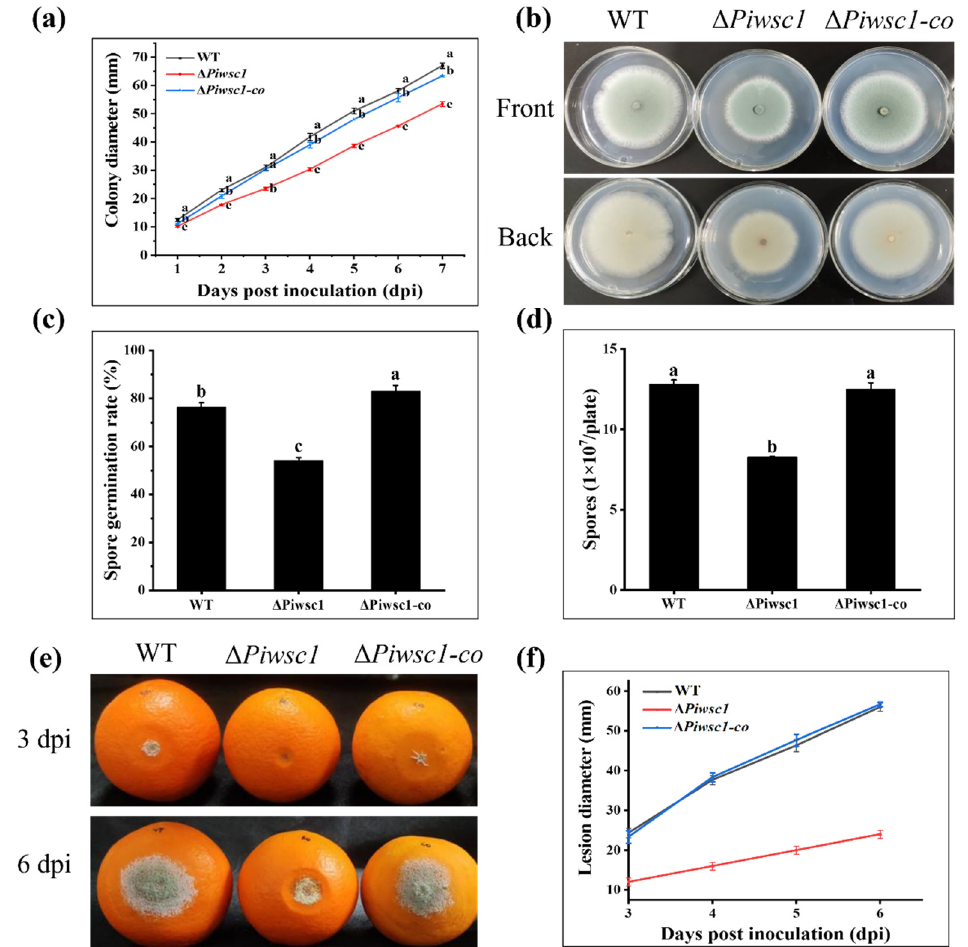
Figure 5. Effect of Piwsc1 deletion on P. italicum radial growth, sporulation, spore germination, and virulence. Radial growth diameter changes ( a ) and colony morphology at 7 dpi ( b ), spore germination rate at 10 hpi ( c ), and sporulation at 3 dpi ( d ) of WT, Δ Piwsc1 , and Δ Piwsc1-co strains on PDA plates are recorded. Rot status at 3 and 6 dpi ( e ) and lesion diameters from 3 to 6 dpi ( f ) of WT, Δ Piwsc1 , and Δ Piwsc1-co strains on Navel oranges are recorded.